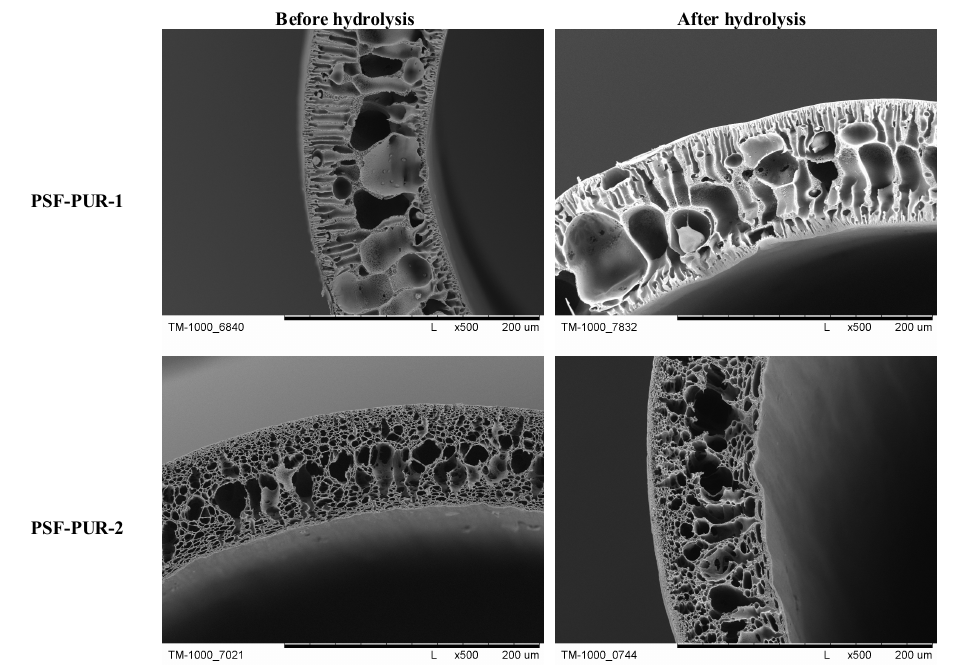
Figure 6. The part of the crosssection of the PSF-PUR-1 and PSF-PUR-2 membranes before and after hydrolysis.